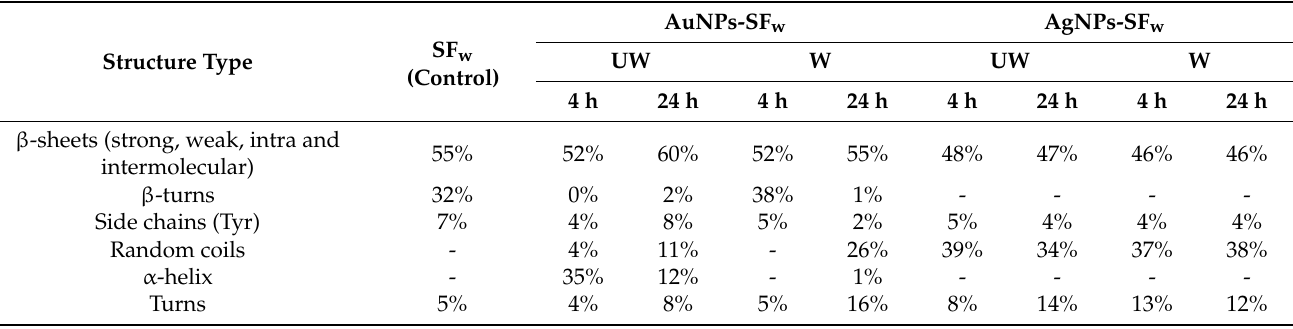
Table 3. Secondary structures present in the vibrational mode of amide I for the treated membranes and functionalized with AuNPs-SF w and AgNPs-SF w for 4 h and 24 h. Non-functionalized treated SF w membranes were used as